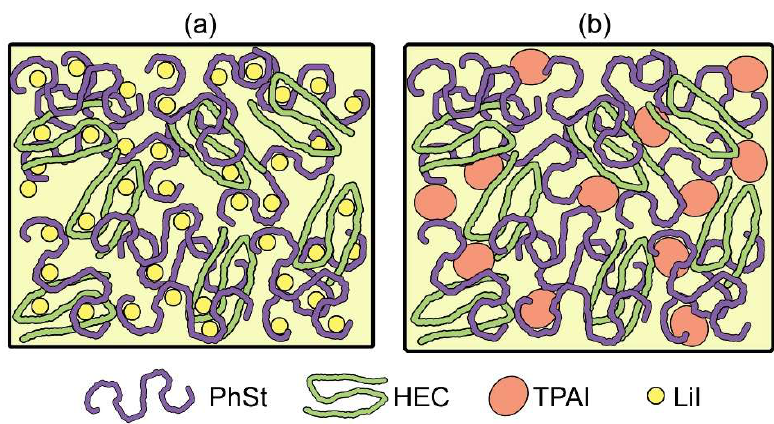
Figure 3. Graphical depiction of ( a ) Li+ and ( b ) TPA+ distribution in gel.